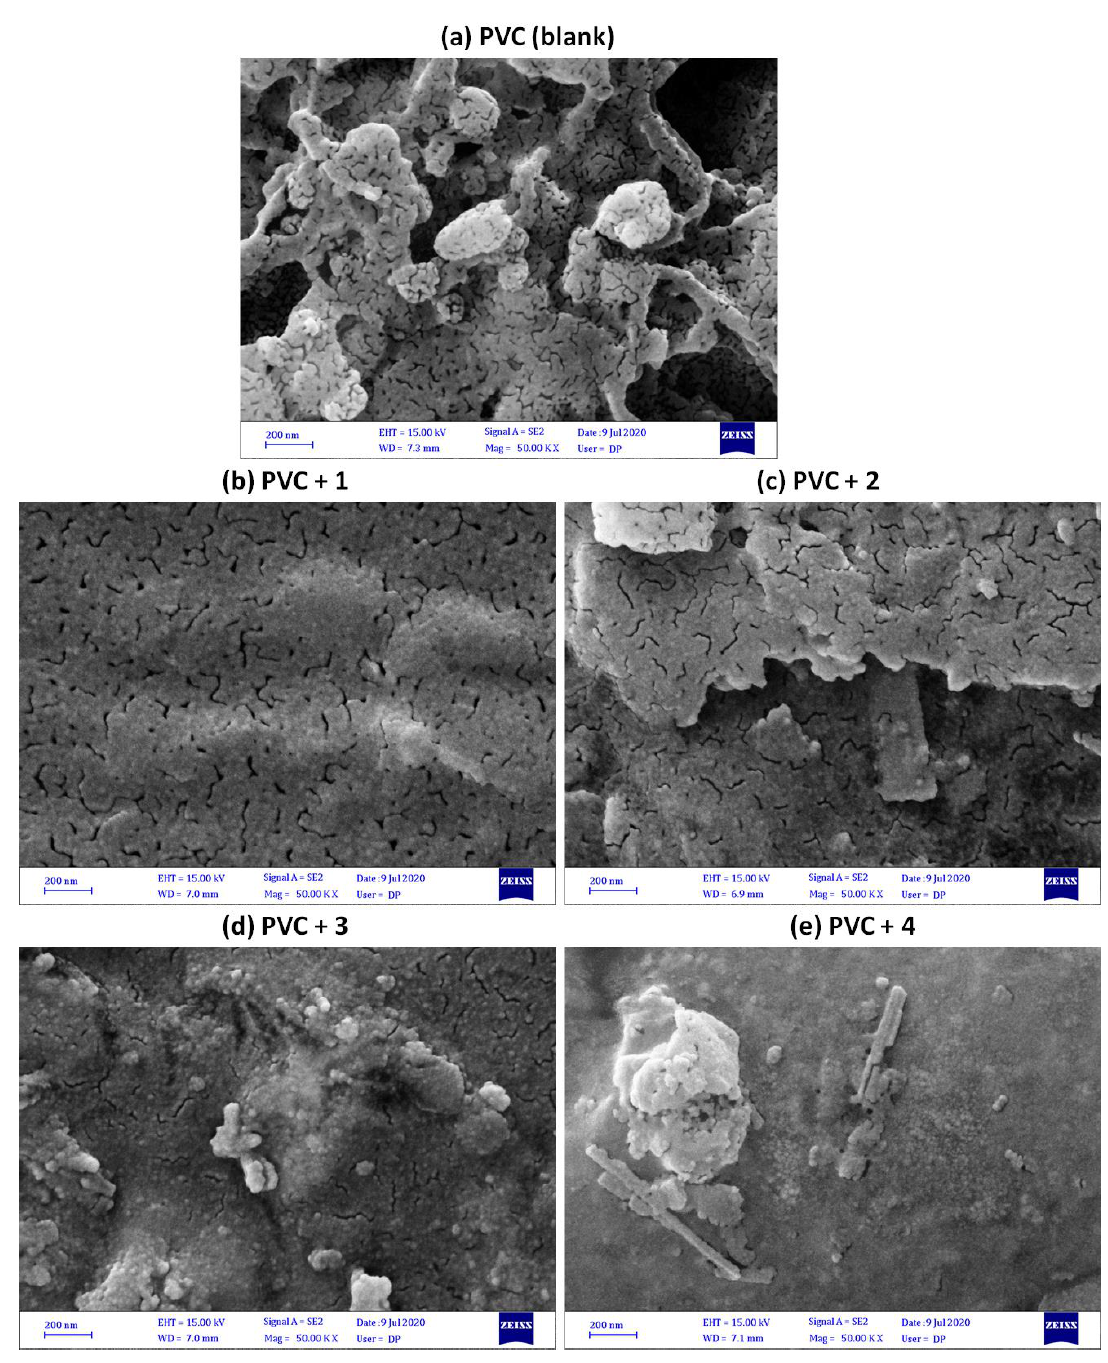
Figure 7. FESEM images for PVC films after irradiation (300 h): ( a ) PVC (blank), ( b ) PVC + 1 , ( c ) PVC + 2 , ( d ) PVC + 3 , and ( e ) PVC + 4 .